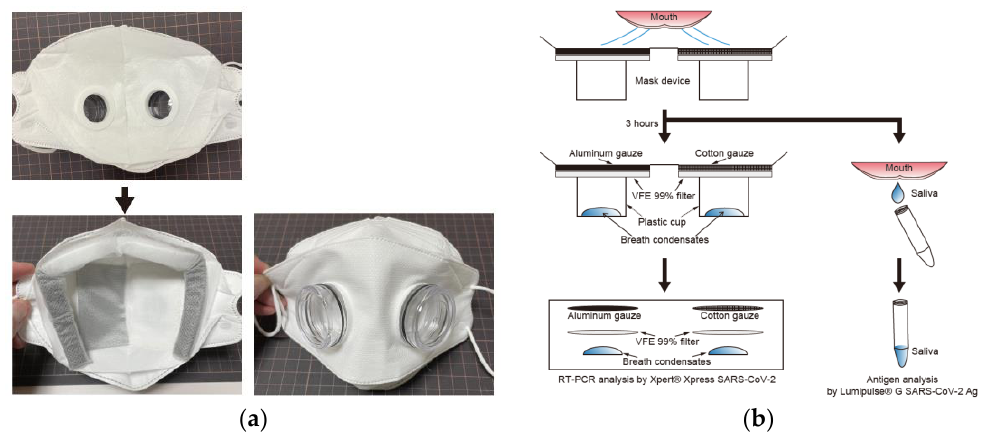
Figure 1. Development of experimental mask. The final model of the experimental mask ( a ) was composed of non-woven masks with an aluminium gauze placed in the left half, a cotton gauze placed in the right half, non-woven filters with 99% VFE, and plastic cups; ( b ) is a brief graphical summary of the